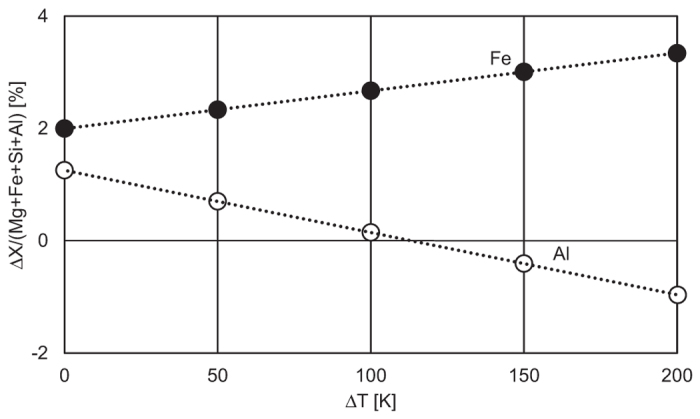
Required ΔX/(Mg + Fe + Si + Al) (X = Fe or Al) to explain the velocity anomaly of +1% for VB and −1% for VS with temperature difference ΔT.Solid and open circles are for Fe and Al, respectively. With increasing ΔT, required ΔFe and ΔAl increases and decreases respectively. When ΔT is around 110 K, the velocity anomaly can be explained only with ΔFe and the distribution of Al should be uniform.